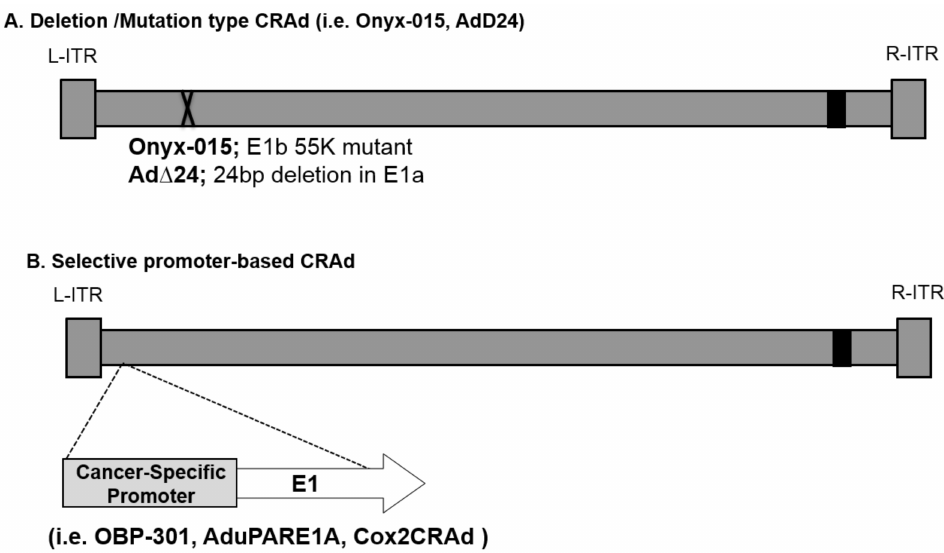
Figure 1. Control mechanisms of oncolytic adenovirus. ( A ) Deletion type Conditionally Replicative Adenovirus (CRAds): this type of CRAd has a mutation/deletion in a region crucial for viral replication. While cancer cells possess the cellular environment to compensate for the missing function of the virus, normal cells do not have that capability. For example, ONYX-015 (dl1520) and Ad ∆ 24 were designed to replicate only in p53 and pRb mutated cells, respectively; ( B ) Selective promoter-based CRAd: A tumor/tissue-specific promoter controls the expression of viral genes crucial for replication. As a result, the virus can replicate only in cells in which the promoter is active. By using a promoter with a tumor-ON/normal cell-OFF profile, the replication can be restricted to cancer